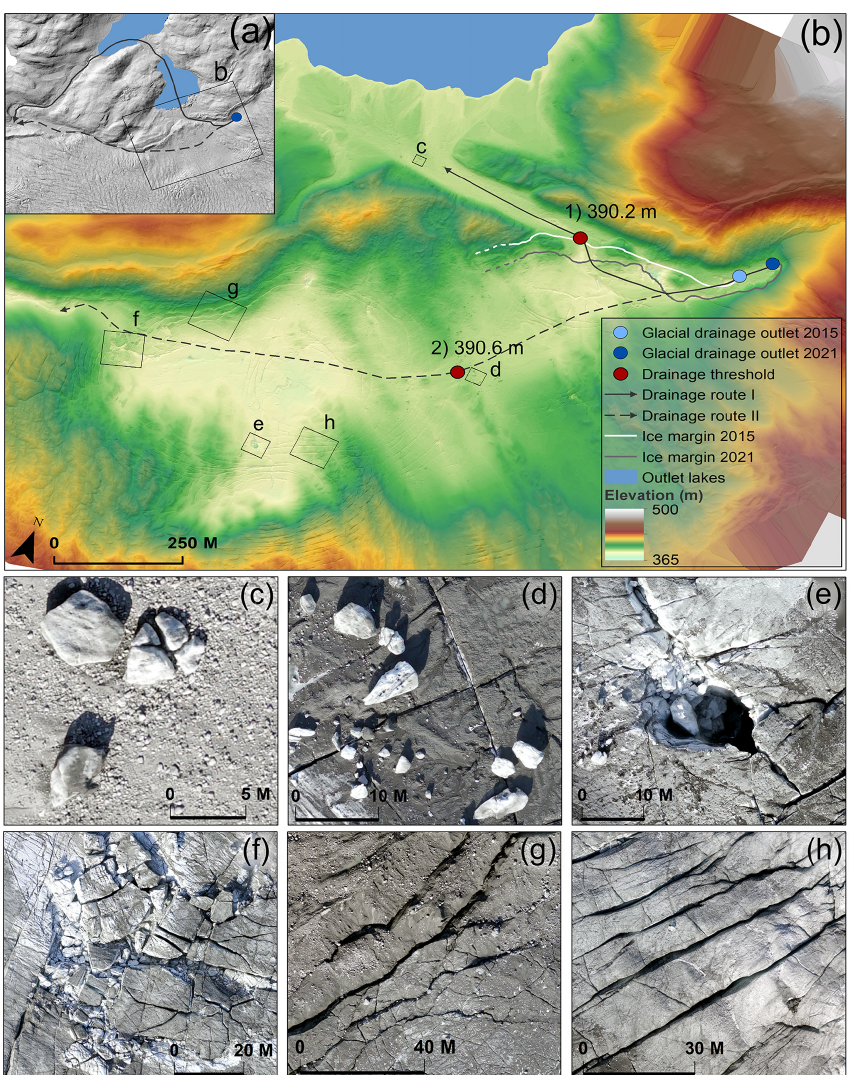
Figure 4. (a) Overview of drainage route I and II overlaid on a hillshade of the ArcticDEM from 2 August 2015. Box indicates the region illustrated in panel (b) . (b) Hillshade of the post-drainage terrain, produced from the Mission I DEM, highlighting where the water exits the glacial drainage outlet. The drainage thresholds indicate the highest elevation points along the drainage routes. The 2015 and 2021 ice margins are digitized based on the ArcticDEM and Mission I DEM, respectively. (c, d) Ice blocks deposited along the two drainage routes, up to 5m in length. (e) Roughly circular and nearly vertical holes, ∼ 10m in diameter, with a total of five such features observed at the ice margin. (f) Fractured ice due to supraglacial water flow. (g, h) Parallel fractures, reaching several hundred metres in